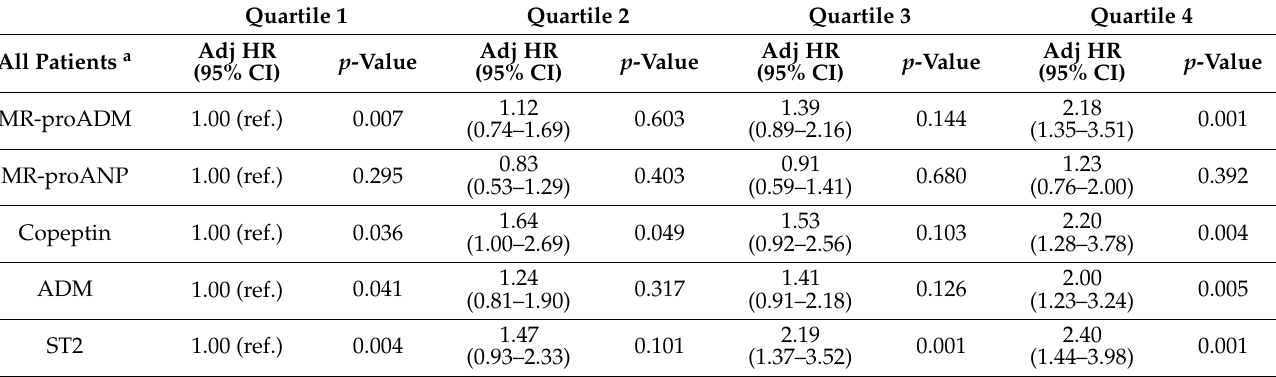
Table 3. Adjusted effects of circulating biomarker levels on overall survival for all patients and by disease